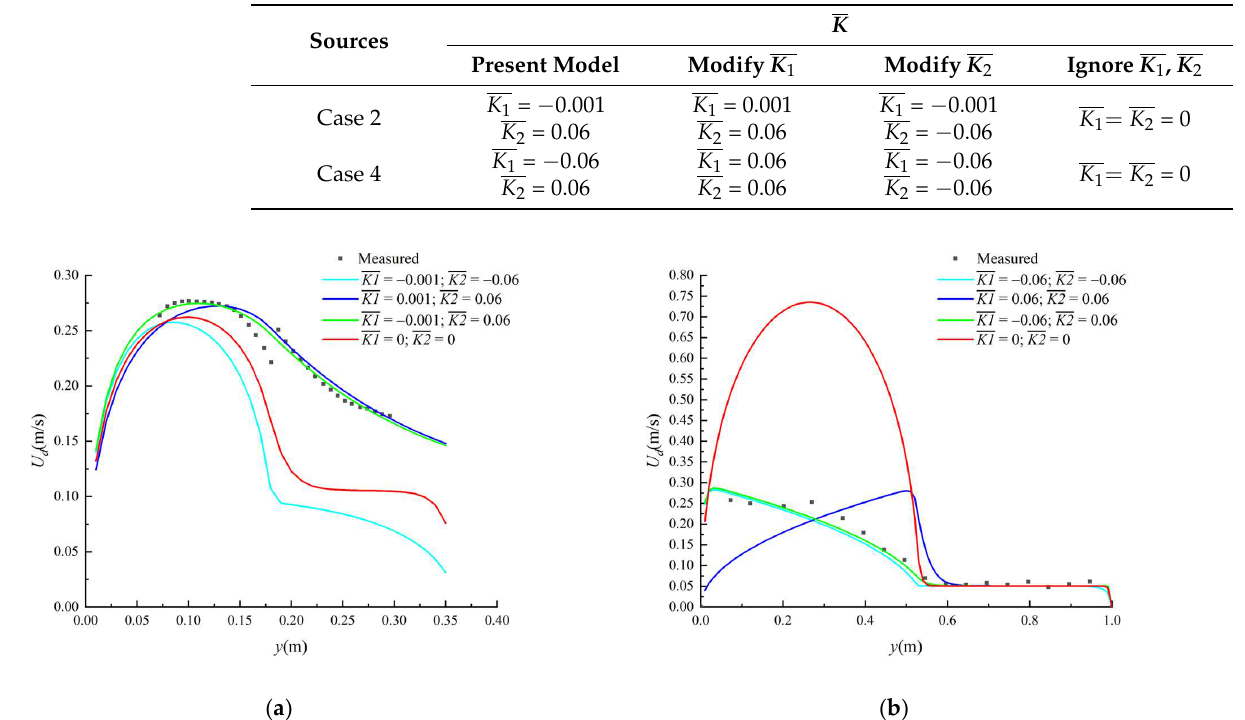
Table 3. Summary of the modification of the K -value.